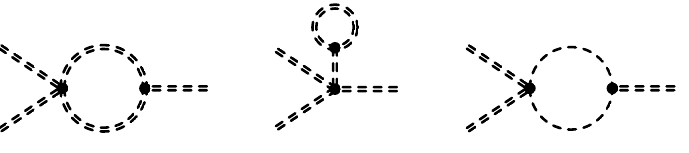
Figure 9 . Examples of one-loop contributions to the renormalisation of the coupling (cid:22) . The line styles and their meanings resemble those of (cid:12)gure